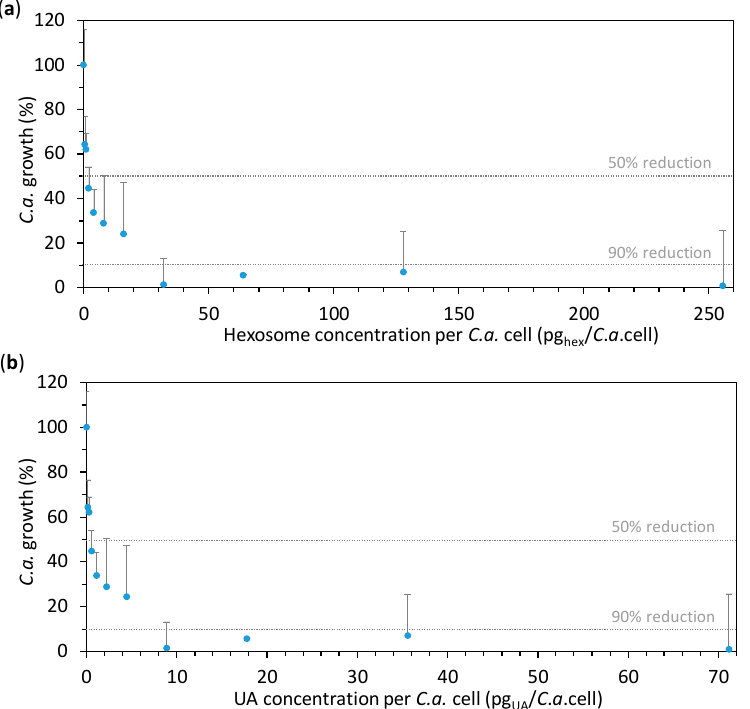
Figure 3. The effect of hexosomes on the Candida albicans ( C.a. ) cell growth in the presence of the given concentrations of hexosomes (evaluated by measuring the absorbance at 600 nm, A 600 ). The results obtained for C.a. cells (concentration of 10 5 C.a. cells/mL) after 24 h of incubation are expressed as average percentages of A 600 readings compared to the control (0% hexosomes) versus the concentration: ( a ) of hexosomes per C.a. cell and ( b ) of undecylenic acid (UA) per C.a. cell (all values are given as mean ± standard deviation). The vertical dashed lines indicate 50% and 90% of the C.a. growth reduction.